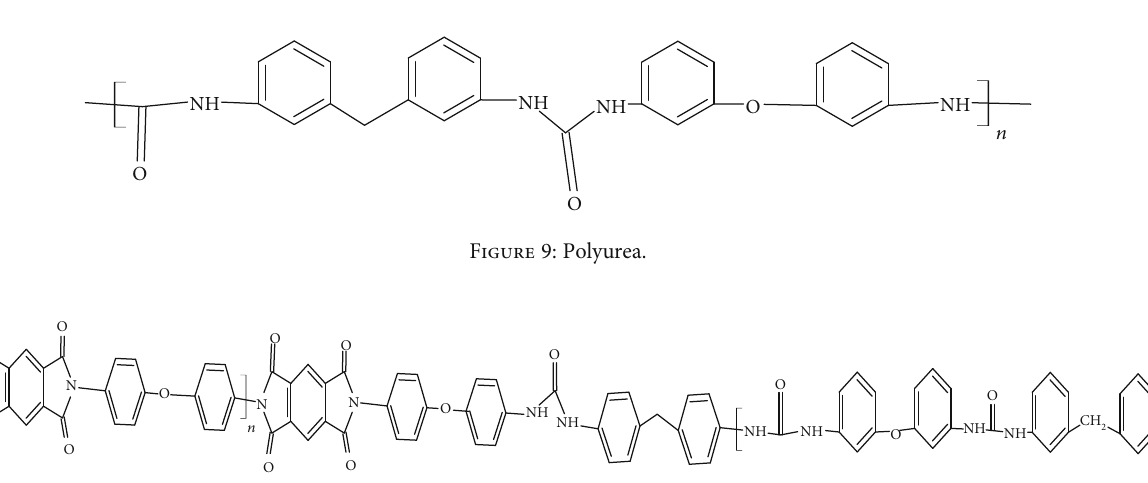
Figure 8: Polyimide polymer.